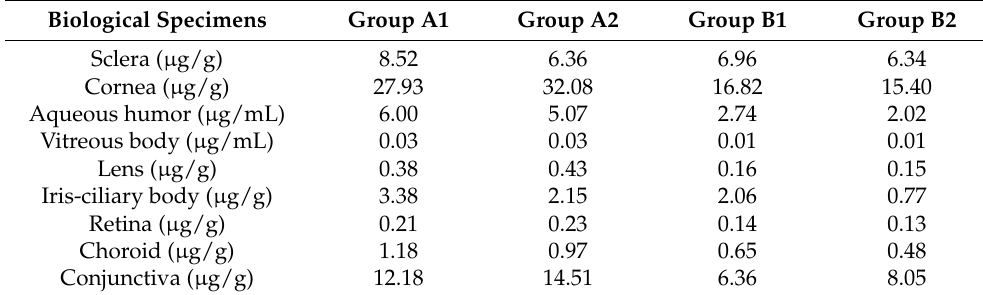
Table 5. C max values of gatifloxacin in ocular